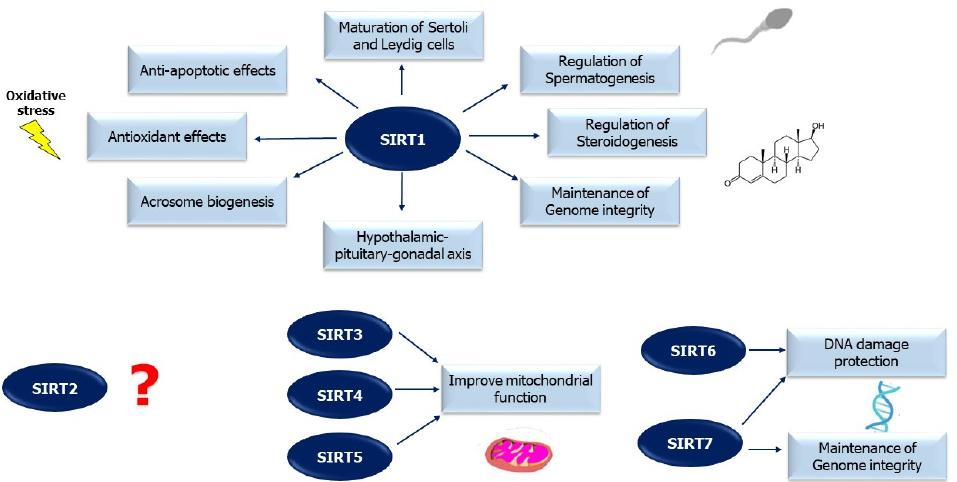
Figure 1 . Sirtuins (SIRT) and male reproduction. This figure summarizes the main effects of SIRTs on male reproductive function. SIRT1, the most studied member of the SIRT family, seems to have a pivotal role in male fertility through several mechanisms. Conversely, the role of SIRT2 in male fertility is completely unknown. There is little data on the relationship between other sirtuins and male male reproduction.